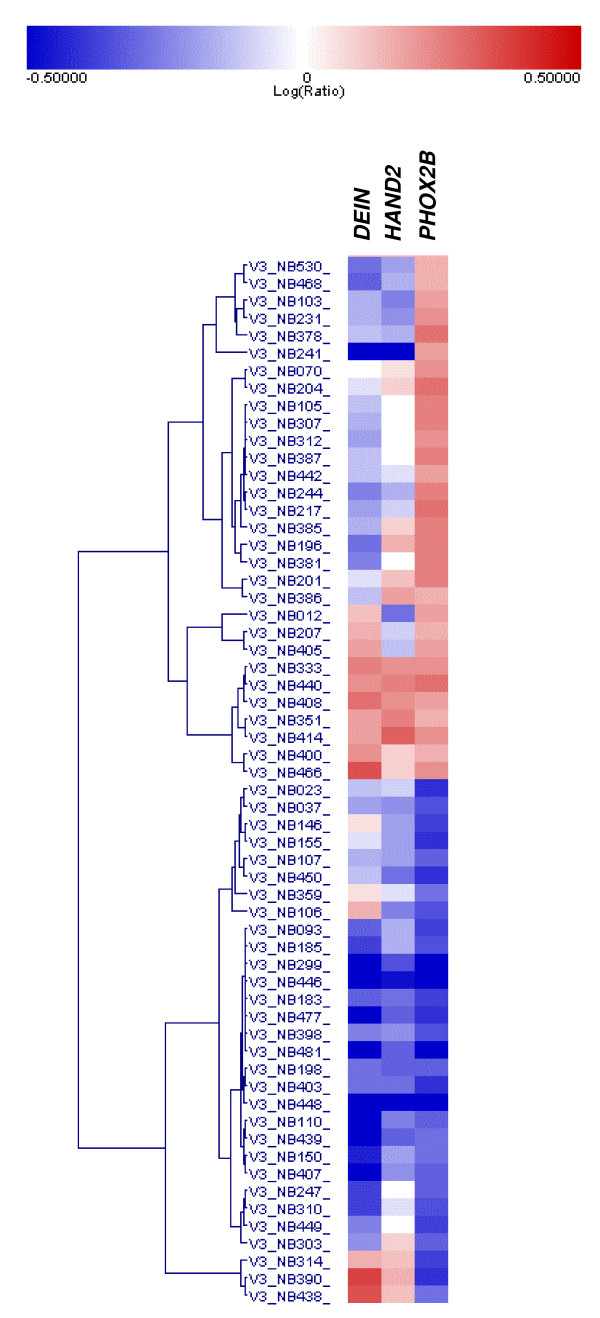
Hierarchical cluster analysis of 60 primary neuroblastomas with high and low PHOX2B expression levels according to expression of DEIN, HAND2 and PHOX2B as determined by microarray analysis. Lines represent patients, columns represent genes. Gene expression levels are visualized as log-values ranging from blue (-0.5) to red (+0.5).